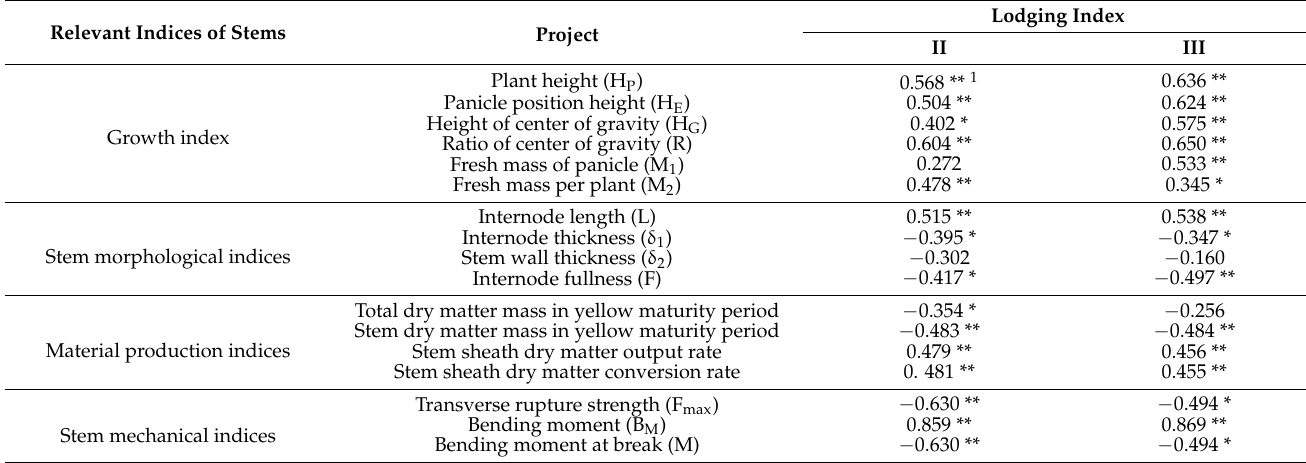
Table 7. Correlation between rice lodging index and stem